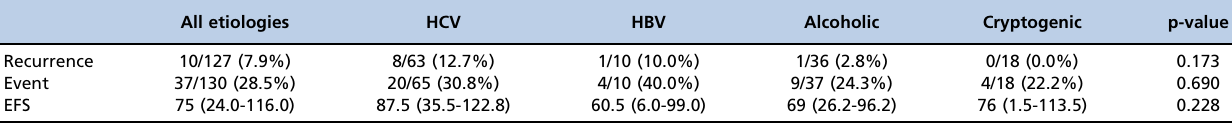
Table 2 - Clinical outcomes according to chronic liver disease etiology. All etiologies HCV HBV Alcoholic Cryptogenic p-value Recurrence 10/127 (7.9%) 8/63 (12.7%) 1/10 (10.0%) 1/36 (2.8%) 0/18 (0.0%) 0.173 Event 37/130 (28.5%) 20/65 (30.8%) 4/10 (40.0%) 9/37 (24.3%) 4/18 (22.2%) 0.690 EFS 75 (24.0-116.0) 87.5 (35.5-122.8) 60.5 (6.0-99.0)